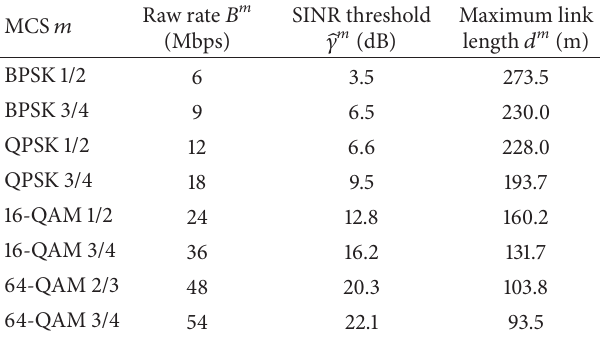
Table 2: IEEE 802.11a MCS, FER 61%, and 1500-byte payload. Table 3: Computing times